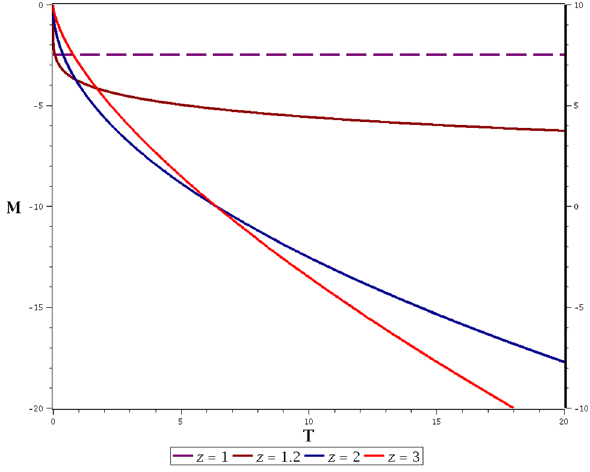
Fig. 11 Massasfunctionofthetemperatureforthefixedvalues D = 5, V = 1, κ = 1 and b = 1. T and M are as in the restricted parameter case (73). It is displayed how configurations with z > 1 and sufficiently high temperature are preferred as a lower energy state